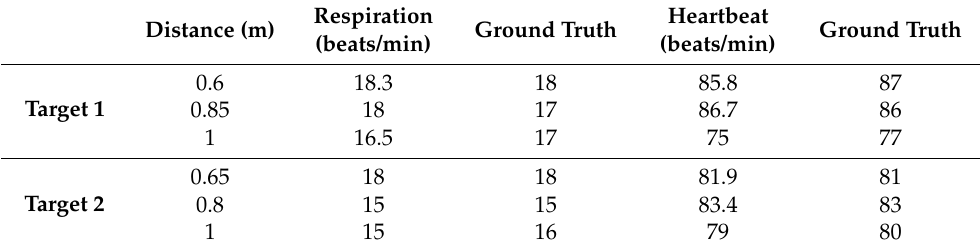
Table 2. Vital sign results for both targets.